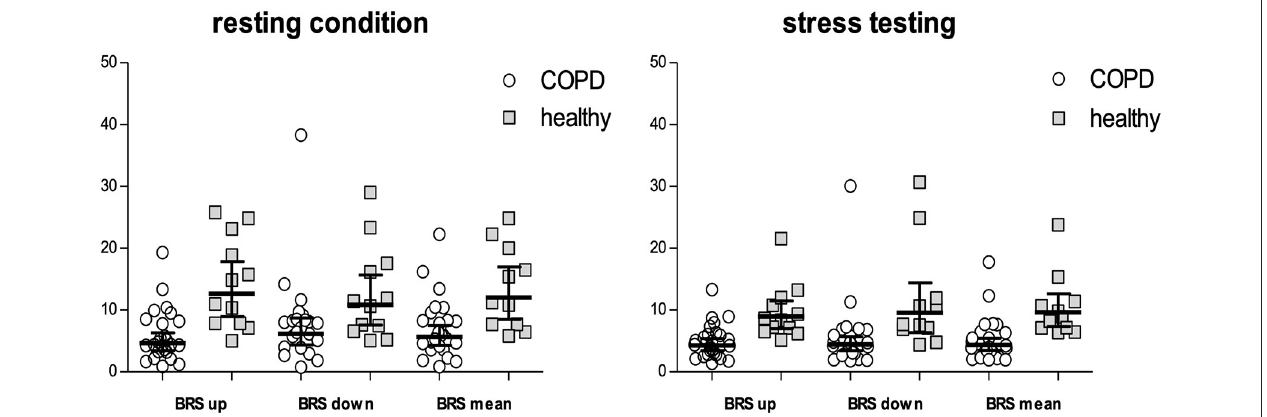
FIGURE 2 | BRSup, BRSdown and BRSmean either during resting conditions as well as mental arithmetic stress testing. Values are indicated as geometric means with 95% CI. Values of COPD patients are shown by circles, values of the healthy population by squares. BRS, baroreceptor reflex sensitivity; BRSup, mean slope of sequences characterized by progressive increase in pulse interval and systolic blood pressure; BRSdown, mean slope of sequences characterized by progressive decrease in pulse interval and systolic blood pressure; BRSmean, mean of BRSup and BRSdown.